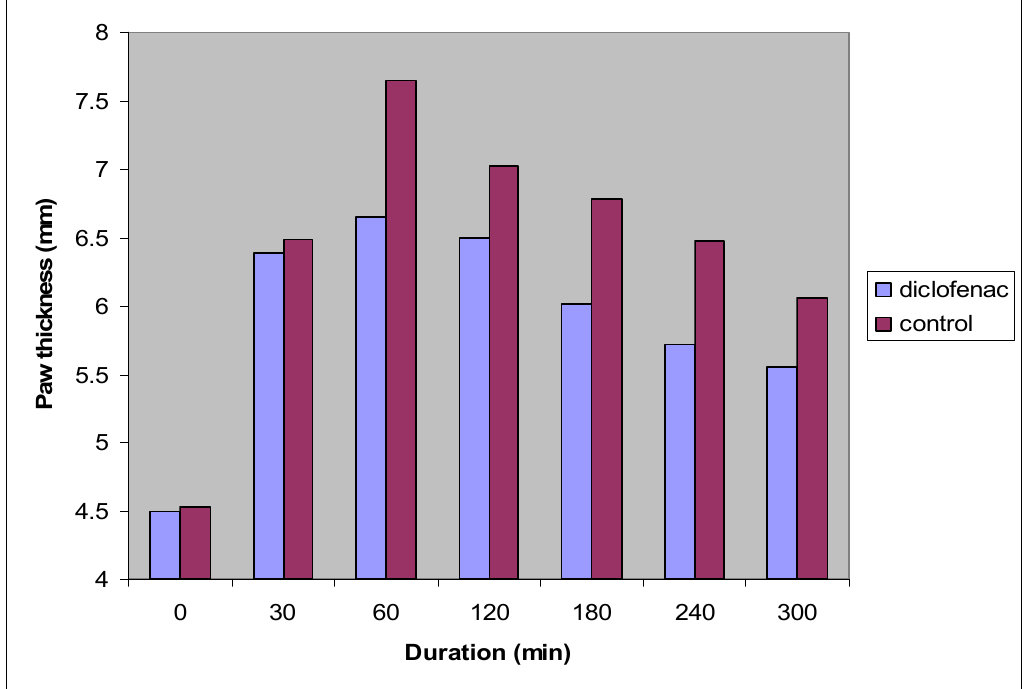
Figure 2. Effect of diclofenac sodium (reference), and propylene glycol (control) on egg-white induced paw edema in rats. Time (30) is the time of egg-white